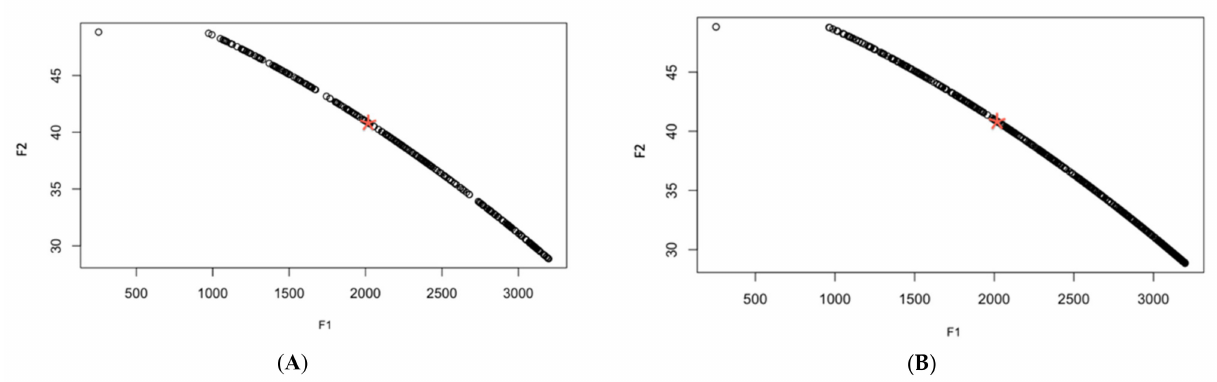
Figure 8. Non-dominated pareto front of the guardian phase of the problem. Where, Black circles are solutions belong to PF, while red star indicates the selected solution ∆ t gc = 8.3335 and v gc = 0.8752. ( A ) NSGA-II, ( B ) CENSGA.